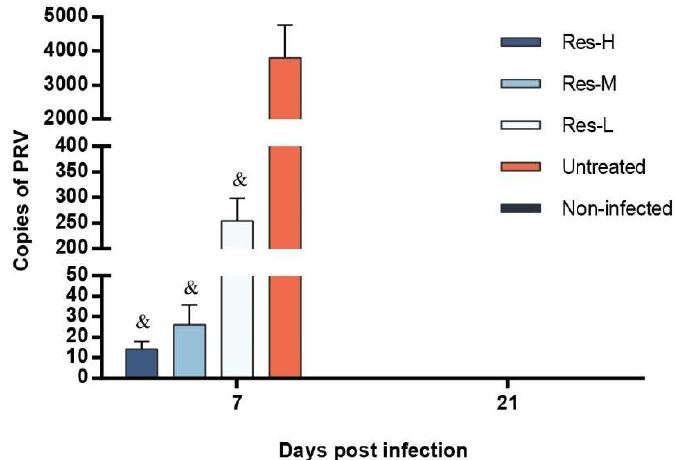
Figure 3. Copies of PRV genome per microgram brain of piglets. Copies of the PRV genome in the brain of the piglets were analyzed by FQ-PCR at 7 and 21 dpi ( n = 3 in each group). There was no PRV genome detected in the non-infected group at any time point and no PRV genome detected at 21 dpi among the groups. Correlation analyses were evaluated by Pearson r2, & p < 0.001 vs. untreated group.